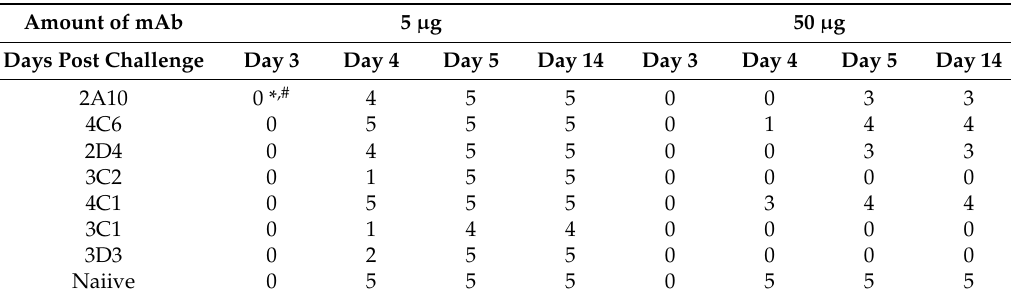
Table 3. In vivo neutralization assay.